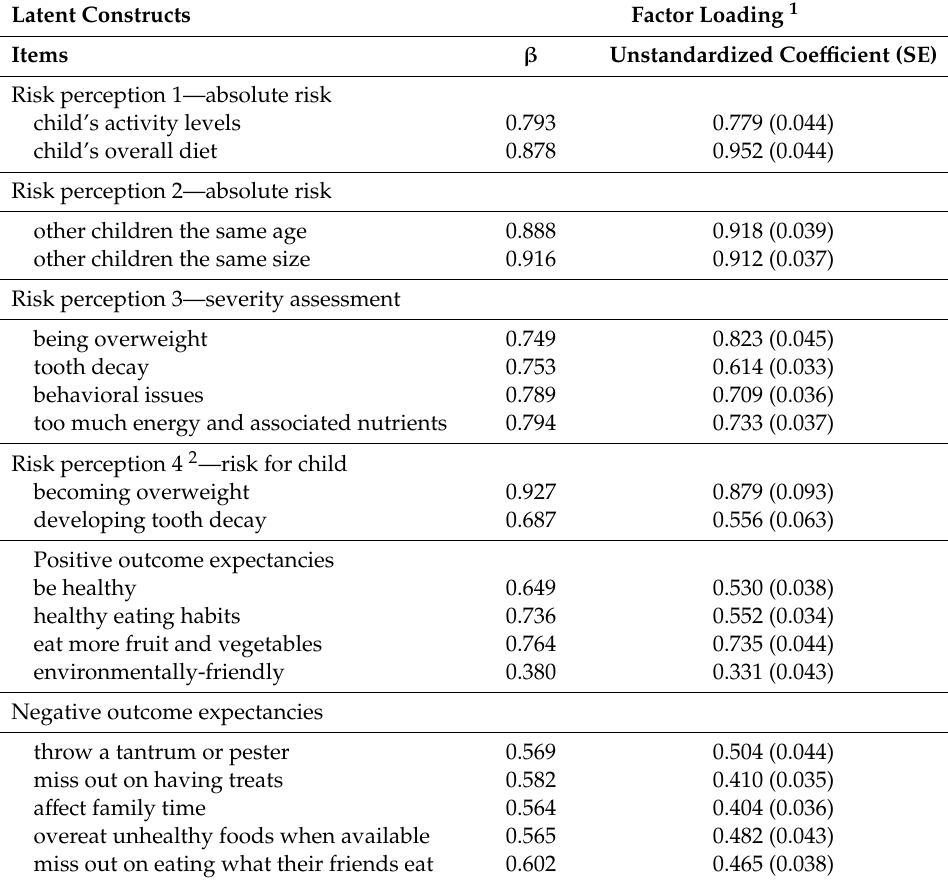
Table 2. Final one factor model confirmatory factor analysis regression weights for motivational phase latent